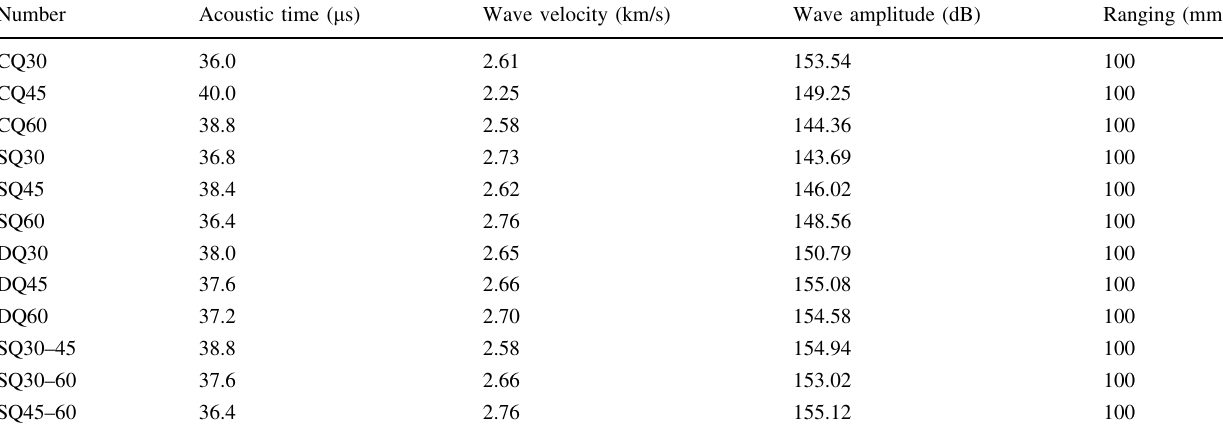
Table 4 Acoustic parameters of the test block before uniaxial